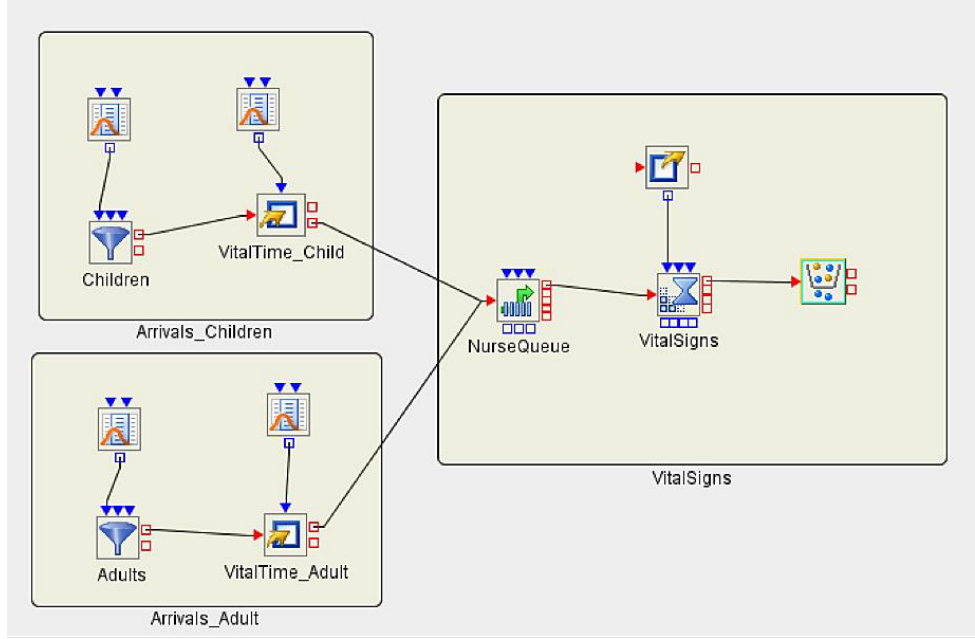
Figure 3. Simulation for an urgent care clinic (second component).